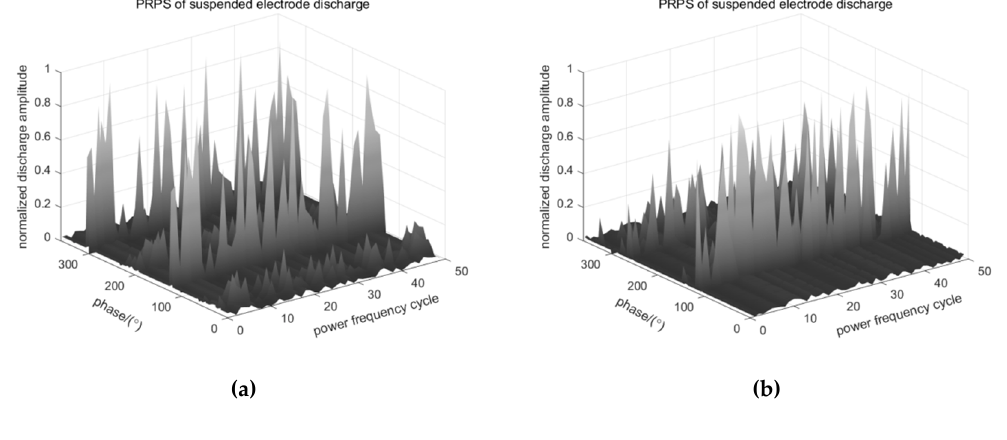
Figure 4. 3D PRPS graphs under four types of insulation defects ( a ) 3D graphs of phase resolved pulse sequence (PRPS) under free metal particles defect at 13 kV; ( b ) 3D graphs of PRPS under suspended electrode defect at 22.6 kV; ( c ) 3D graphs of PRPS under metal tip defect at 6.5 kV; ( d ) 3D graphs of PRPS under air gap defect at 5.5 kV.